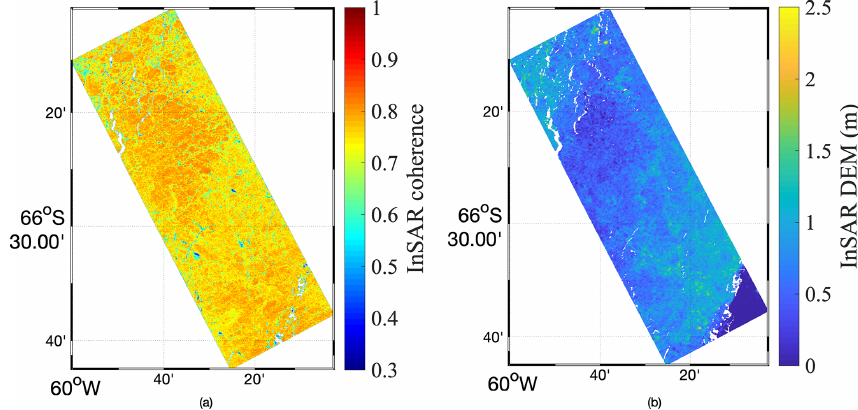
Figure 3. (a) Magnitude of the interferometric coherence | ˜ γ InSAR | and (b) InSAR DEM h InSAR for HH polarization.